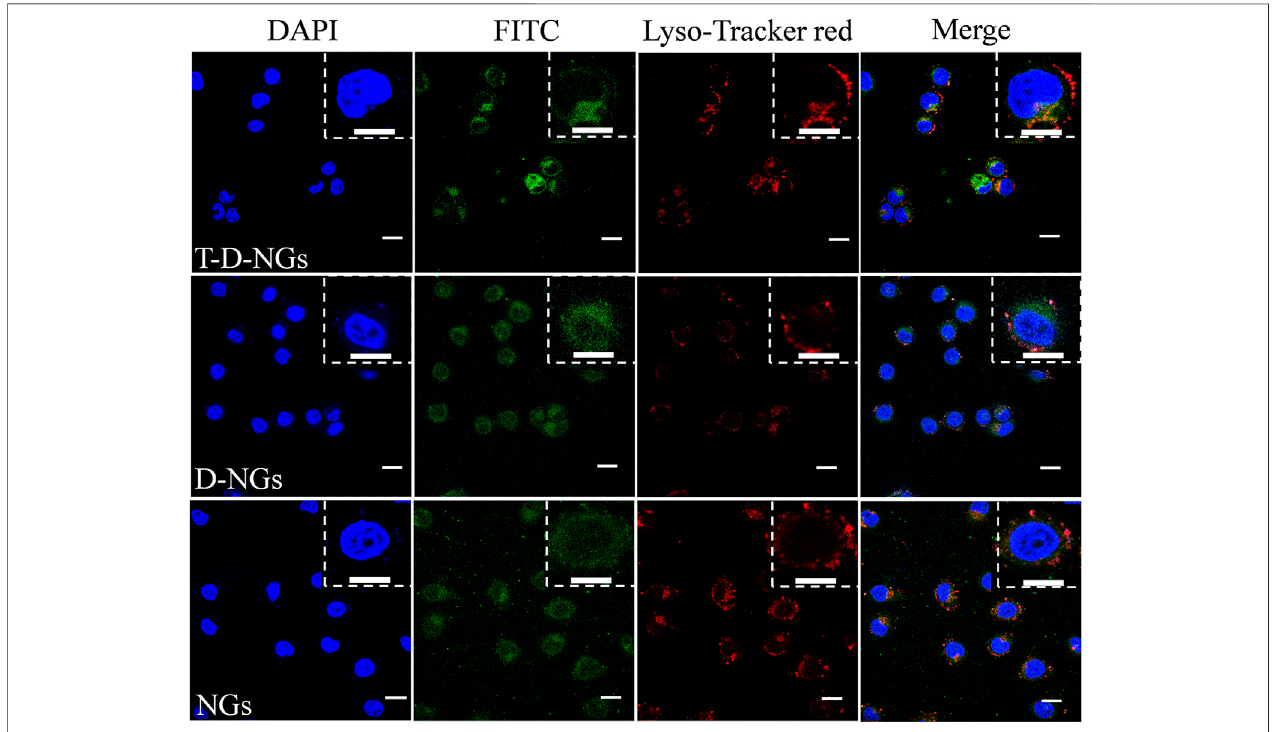
FIGURE3| CLSMimagesofMCF-7/MDRcellstreatedwithdifferentFITC-labelednanogels(500 μ g/ml)following8-hincubation.Thelysosomeswerestainedwith LysoTracker Red, and the cell nuclei were stained with DAPI (blue signal). Scale bar: 20 μ m. CLSM, confocal laser microscope; FITC, fl uorescein isothiocyanate; DAPI, 4 ′